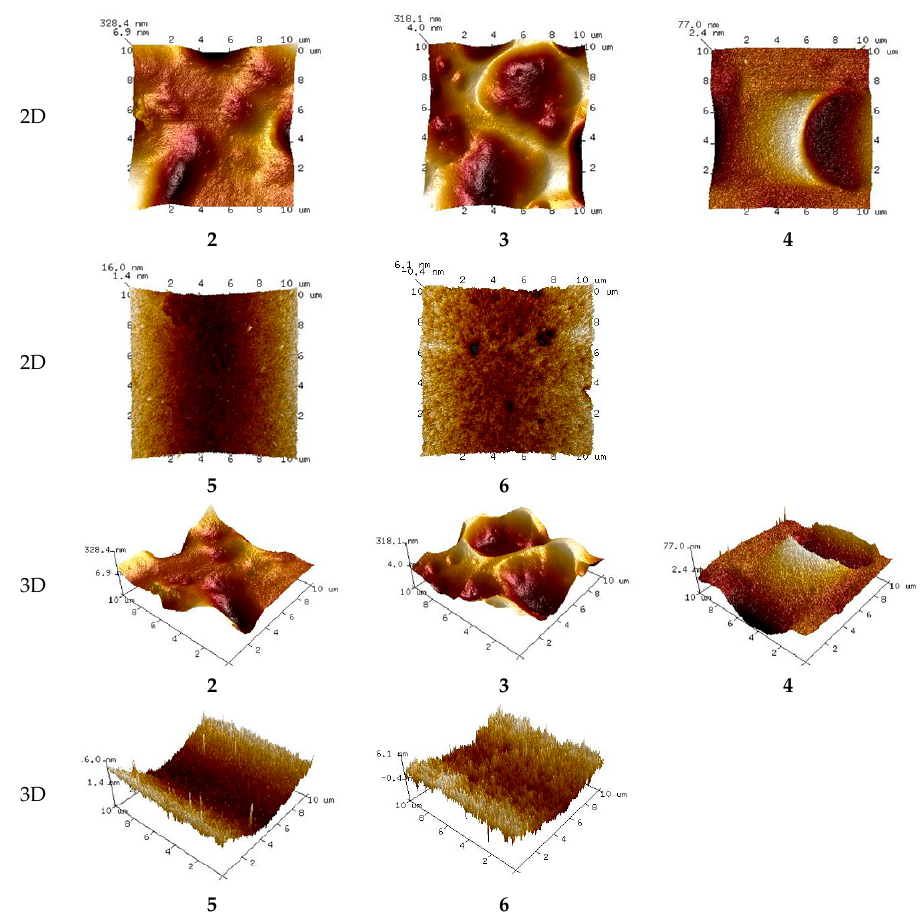
Figure 3. 2D and 3D-atomic force microscopy (AFM) images of PIMs with an increasing percentage of carrier (acac): ( 2 ), ( 3 ), ( 4 ), ( 5 ), and ( 6 ), the composition of membranes is given in Table 2.